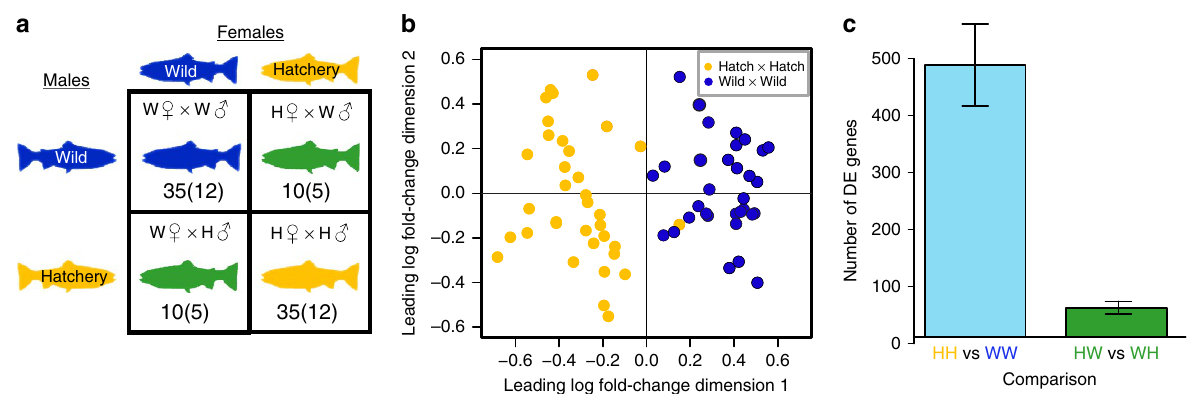
Figure 1 | Genome-wide differences in gene expression between the offspring of first-generation hatchery fish and wild fish reared in an identical environment. ( a ) Both first-generation hatchery fish (H) and wild fish (W) were crossed in the hatchery to create offspring with two wild parents (W (cid:2) W), two hatchery parents (H (cid:2) H), one hatchery mother and one wild father (H (cid:2) W), or one wild mother and one hatchery father (W (cid:2) H). Numbers represent the total number of individuals and families (in parentheses) sequenced in this study. ( b ) Multidimensional scaling plot illustrating the differences in the gene expression profiles for the offspring of first-generation hatchery fish (H (cid:2) H; yellow circles) and the offspring of wild fish (W (cid:2) W; blue circles). A total of 723 genes were differentially expressed between the two groups. ( c ) To compare the main effect (H (cid:2) H vs W (cid:2) W) with background rates of differential expression expected between two groups of families having equal hatchery backgrounds, we compared the number of genes differentially expressed between H (cid:2) W and W (cid:2) H fish vs H (cid:2) H and W (cid:2) W fish from the 5 matrices in which all cross types were sequenced. There were 426 more differentially expressed genes in the H (cid:2) H vs W (cid:2) W comparison than in the H (cid:2) W vs W (cid:2) H comparison. To account for siblings we randomly sampled one offspring per family, calculated the number of DE genes, repeated the process 100 times and calculated the mean and 95% confidence intervals (illustrated with error bars; 40 individuals total, 2 siblings per family). This result also suggests that the difference between H (cid:2) H and W (cid:2) W fish is a heritable genetic effect rather than simply a maternal effect of the juvenile environment experienced by the mother.